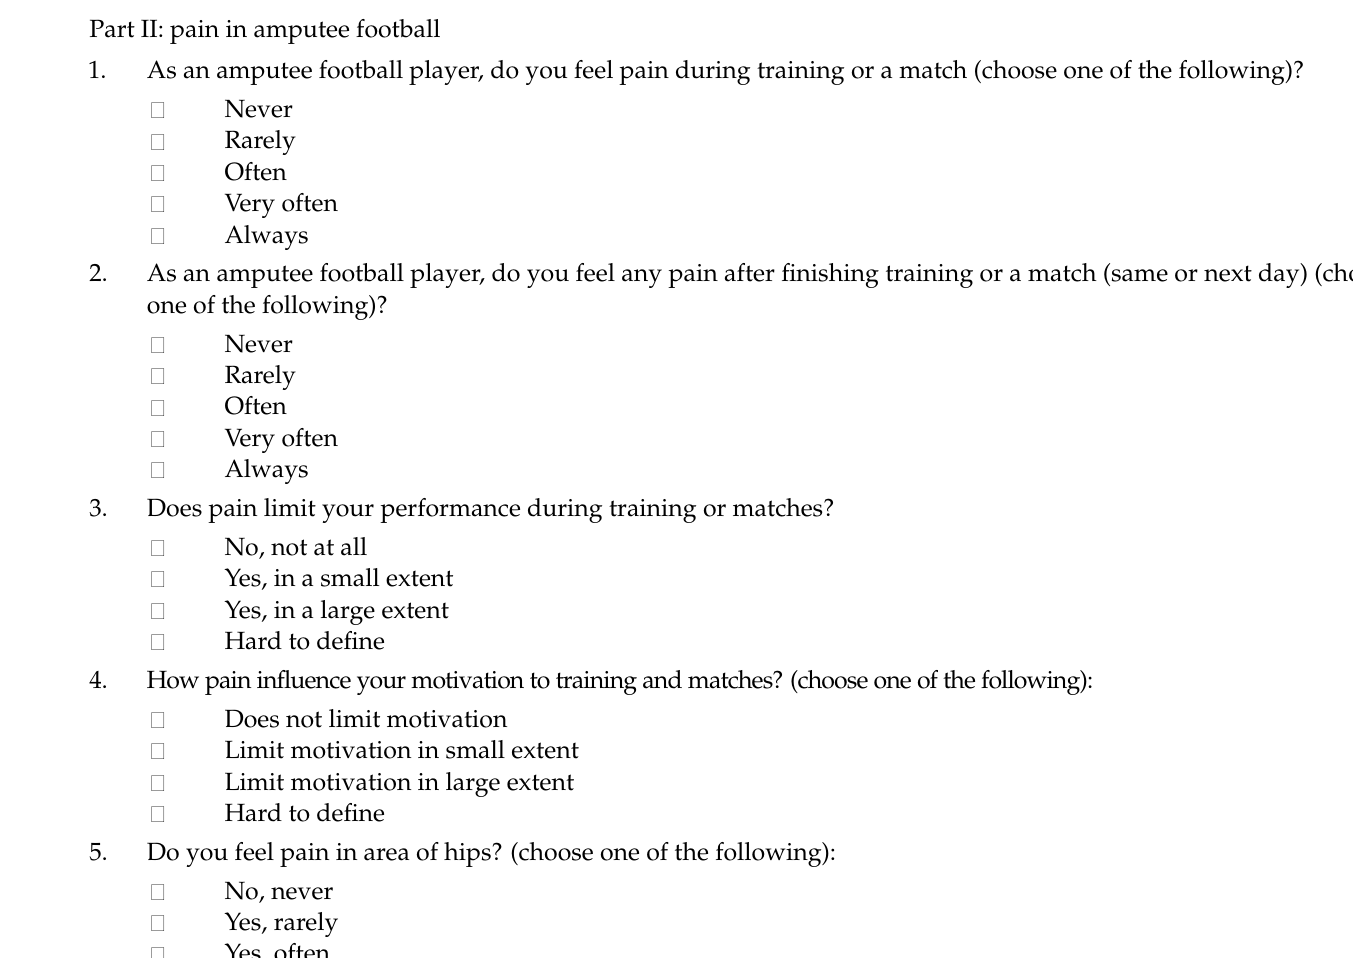
5. Indicate the situation regarding your person (choose one of the following, if you choose “other answer” fill in the gap): amputation as a result of another